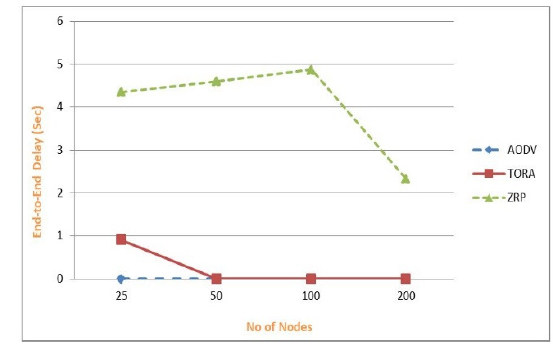
Fig. 2: End - to - End Delay vs. Number of Nodes